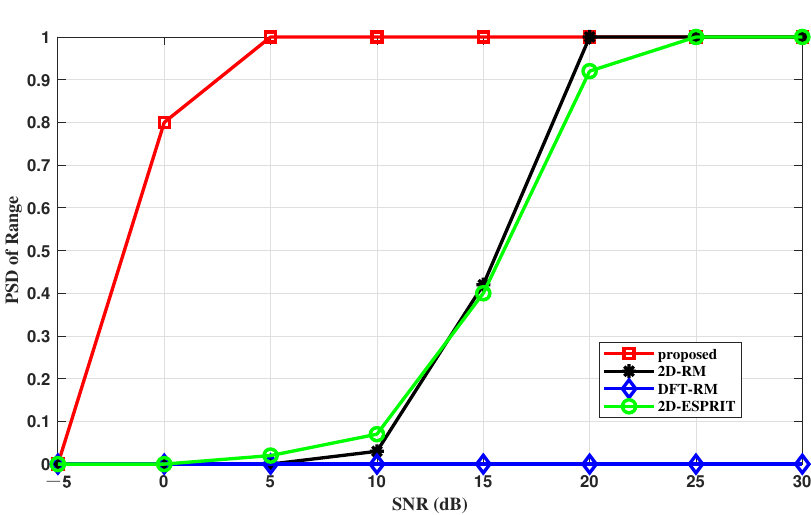
Figure 11. PSD of the range estimation versus